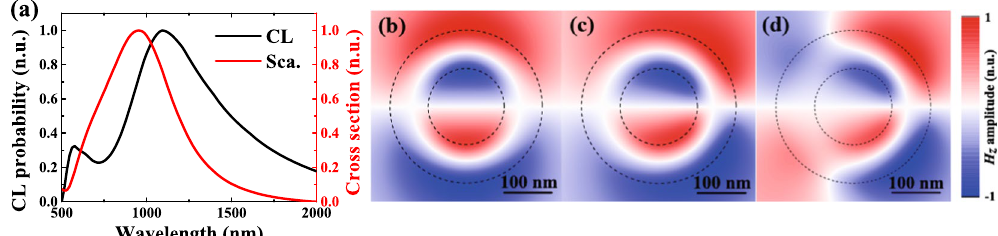
Figure 2. Comparison of the calculated CL and scattering spectra, and the normalized amplitude distributions. ( a ) Calculated CL emission spectrum (black) for a single Au nanoring with inside radius 80 nm and thickness 100 nm surrounded by vacuum, compared to the calculated scattering cross section (red) by plane wave excitation under normal incidence. ( b ) Calculated H z field in x - y plane for r = 80 nm nanoring at λ = 954 nm ( m = 1) by a plane wave excitation. ( c ) and ( d ) show the calculated H z field in x - y plane for the same structure at λ = 1212 nm ( m = 1) and 592 nm ( m = 2) by 30 keV electron beam excitation, respectively. The electron beam was positioned at r = 120 nm and the cuts are taken at 10 nm above the upper surface. The black dashed circles indicate the edge of the